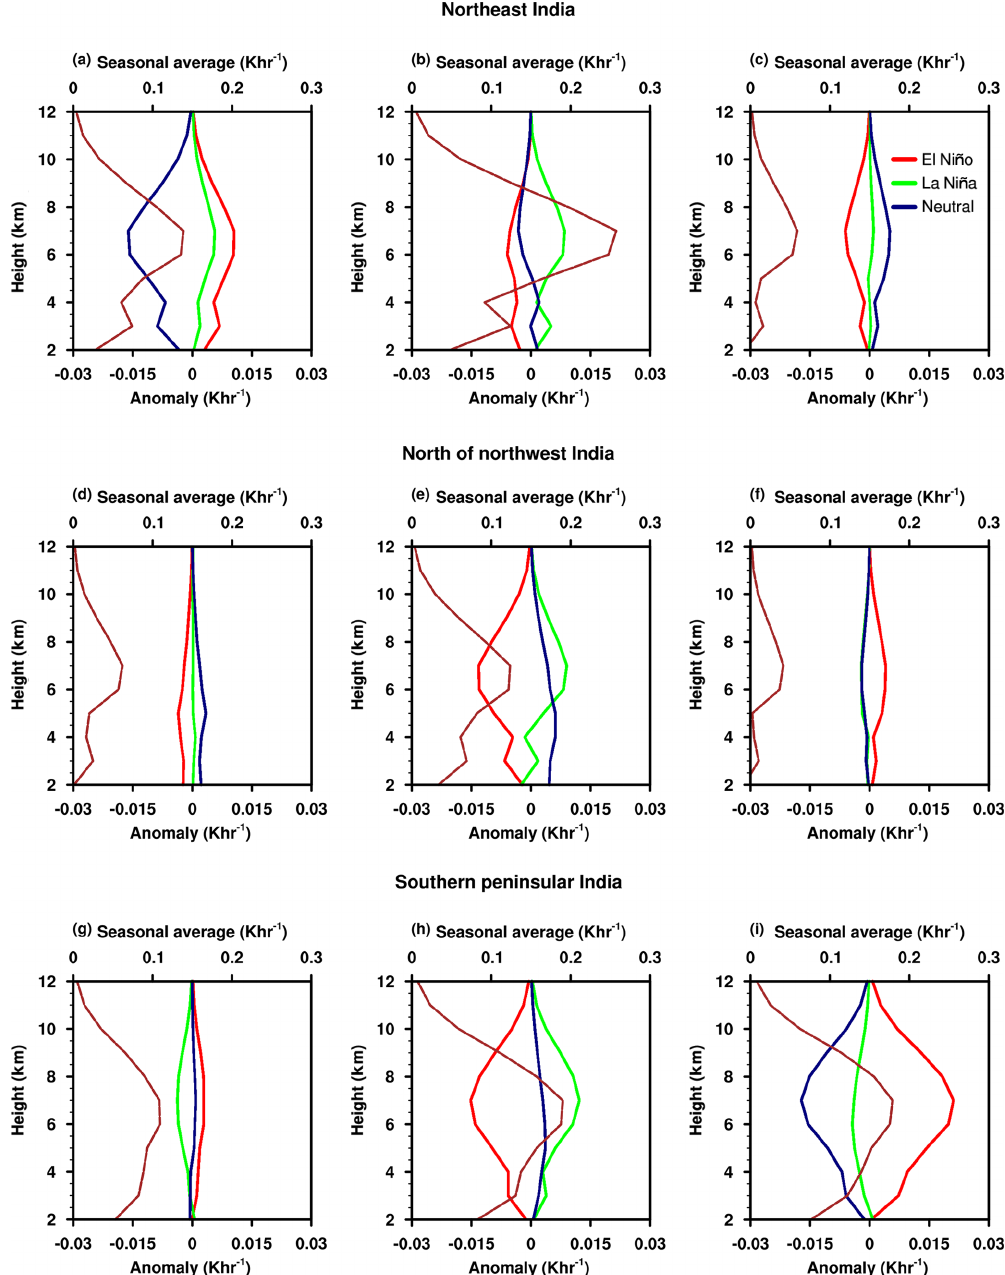
Figure 7. Seasonal average (brown dotted curve) and anomaly composite of latent heat during different ENSO phases. (a, d, g) Premonsoon season. (b, e, h) Monsoon season. (c, f, i) Postmonsoon